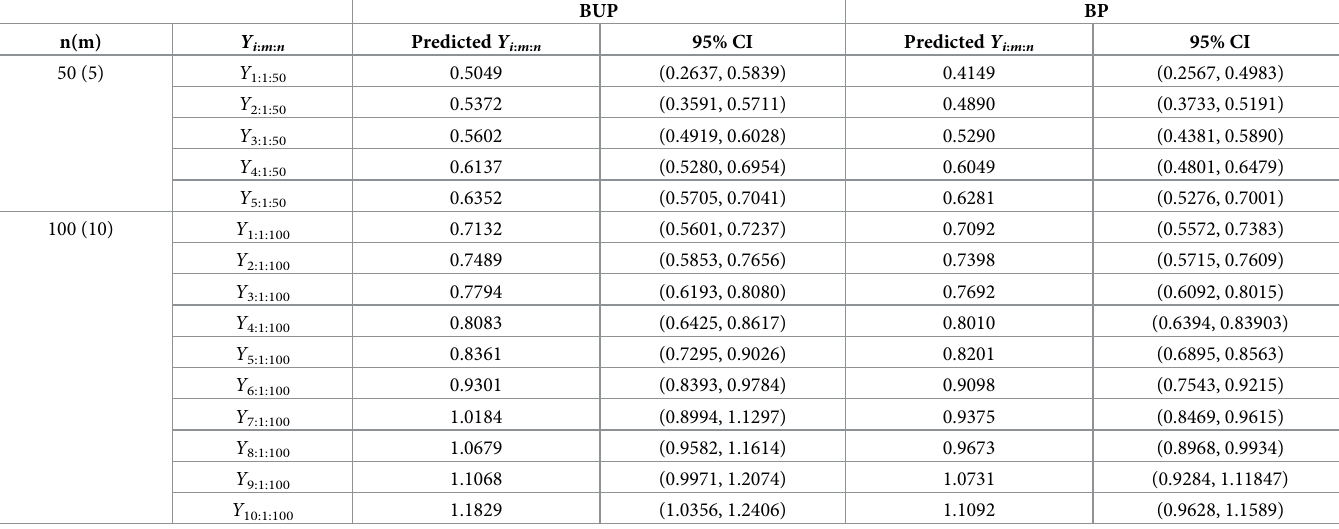
Table 8. Point and interval prediction of the unobserved order statistics Y